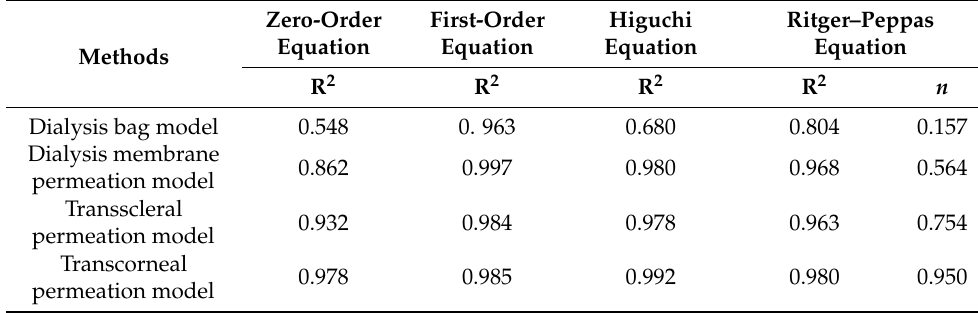
Table 2. Model fitting and parameters of in vitro drug release and permeation